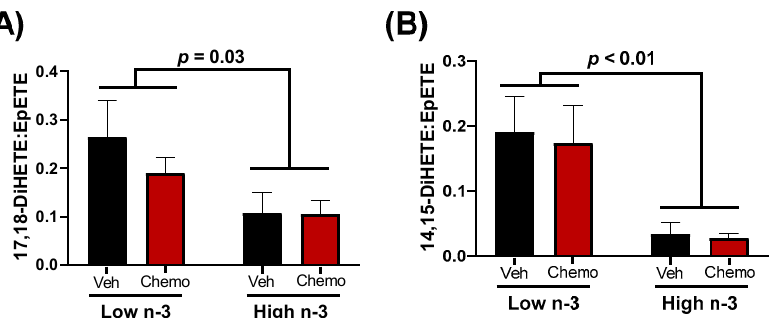
Figure 4. The ratios of the EPA-derived 17,18 ( A ) or 14,15 ( B ) vicinal diol to their corresponding epoxide. Data presented as group means ± SEM ( n = 4/group). A two-way ANOVA with an interaction was used to detect the differences between groups. Veh—saline vehicle injections; Chemo—9 mg/kg anthracycline + 90 mg/kg cyclophosphamide injections; Low n-3—0 g/kg EPA + DHA diet; High n-3—12.2 g/kg EPA + DHA diet (~2% kcal).